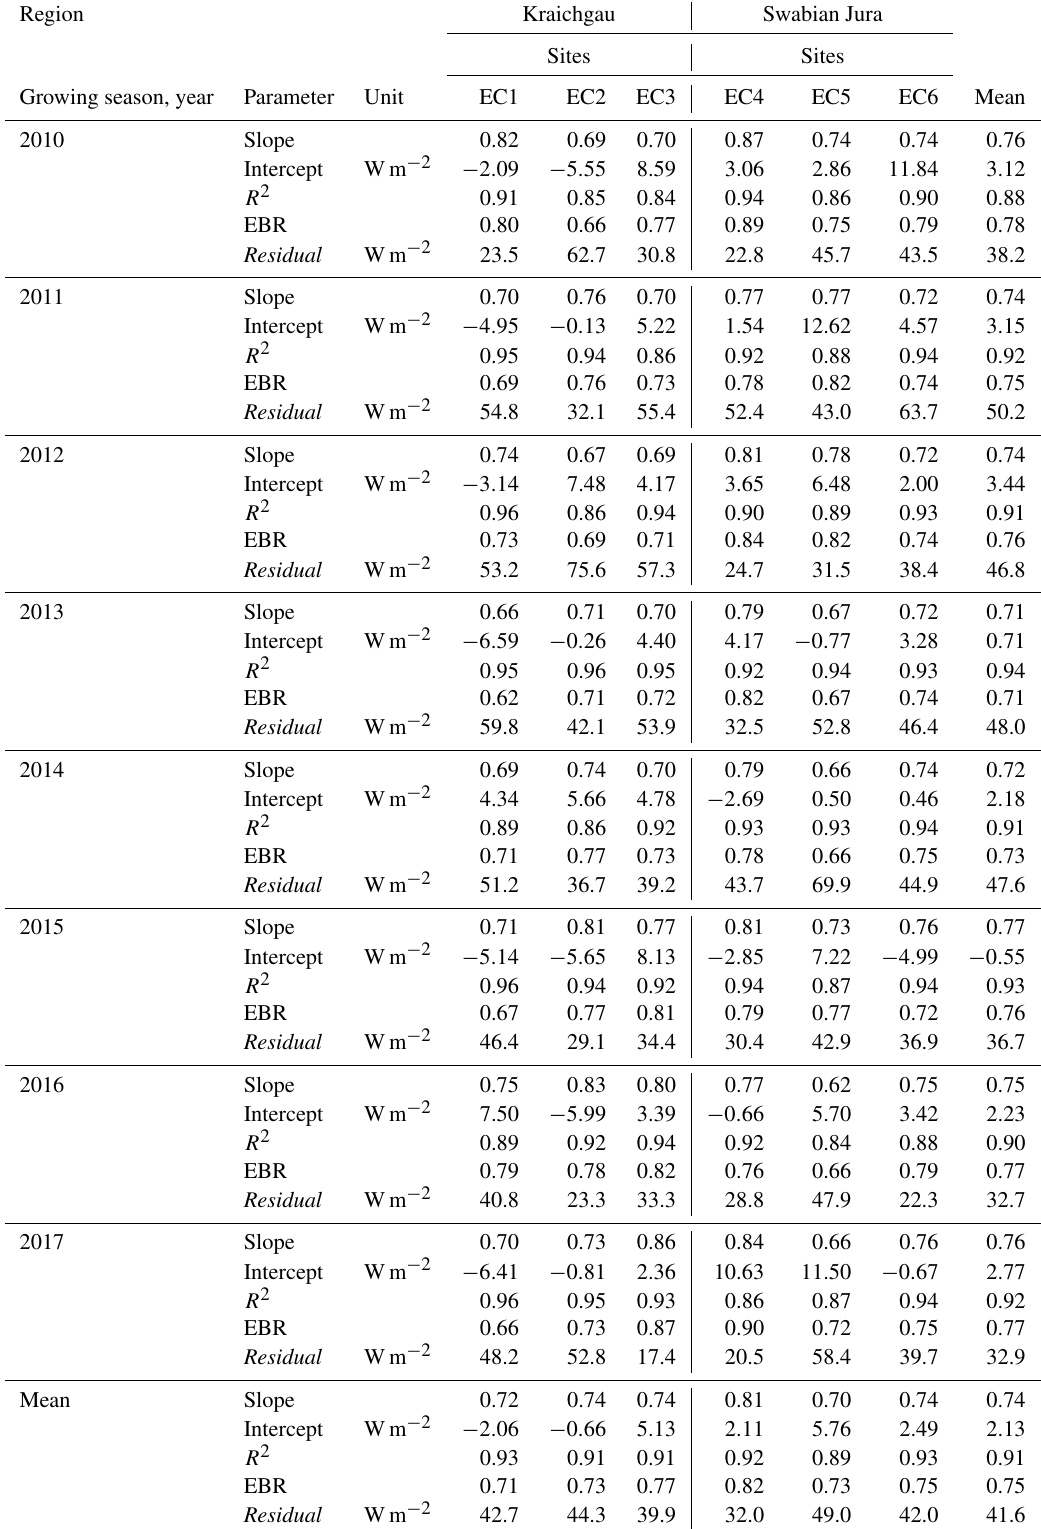
Table 3. Annual mean energy balance closure (EBC; slope of linear regression) and energy balance ratio (EBR) at the eddy-covariance stations EC1 to EC6 in Kraichgau and Swabian Jura during 2010–2017. Regressions are based on half-hourly